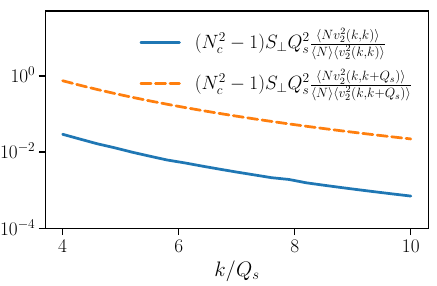
N (cid:5) defined the same momentum of the pair, b the momentum of the pair is offset 2 by the saturation momentum of the target in order to avoid the gluon and the total multiplicity of 2 HBT effect. The bin width in both cases is (cid:10) = Q s / 2. Right panel: the is performed for two cases: a 2 three particle correlation function (cid:4) v 2